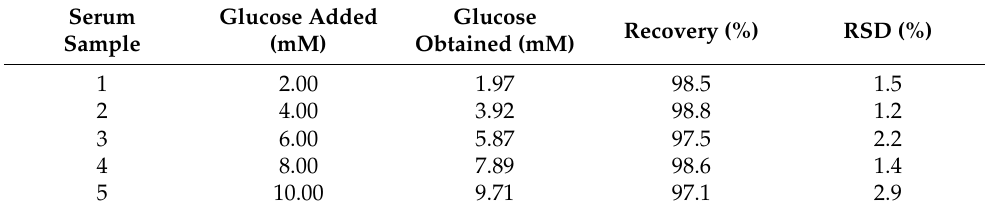
Table 3. Investigation of glucose in blood serum and its